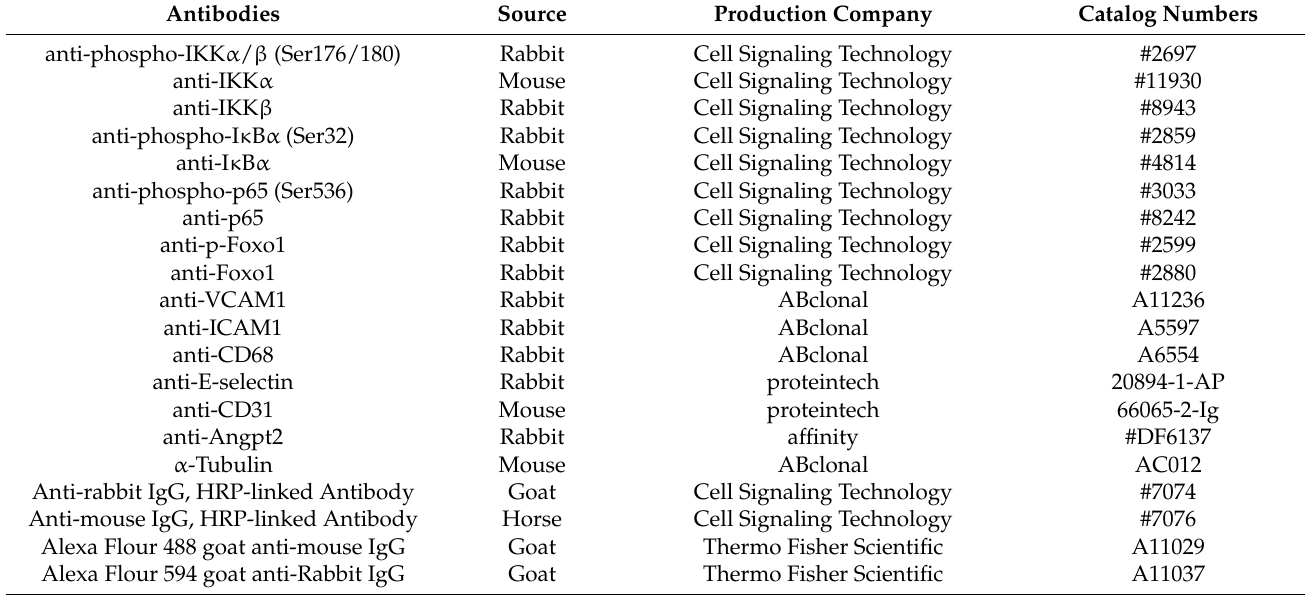
Table 3. Antibody information used in the Western blot and immunofluorescence